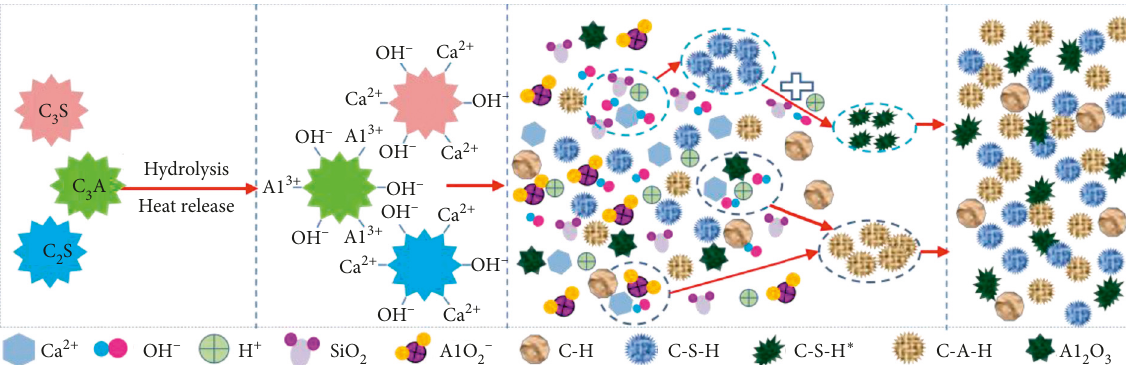
Figure 12: Diagram of the cement hydrolysis and hydration reaction